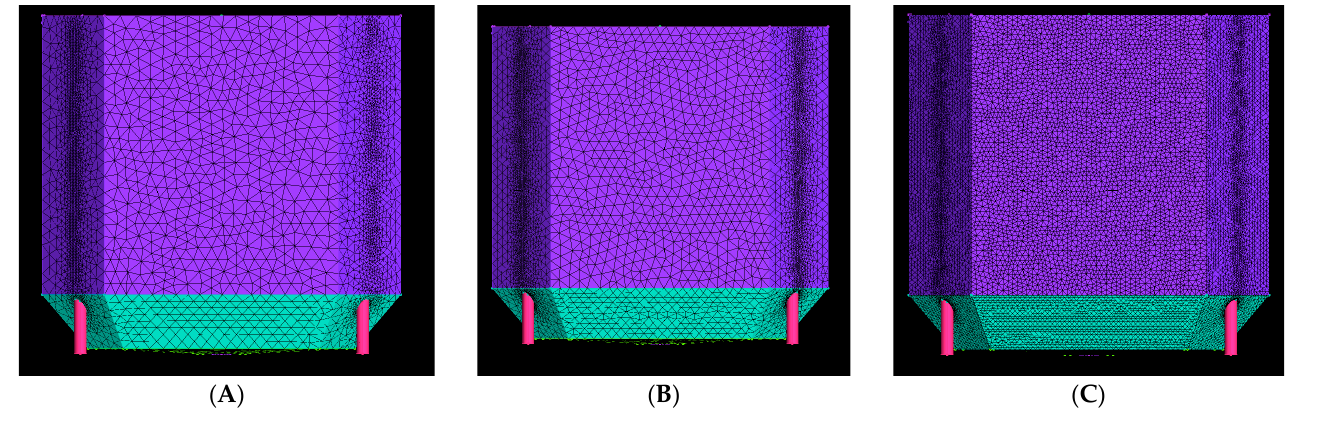
Figure 4. Grid distribution of outlet pipe and bottom outlet.